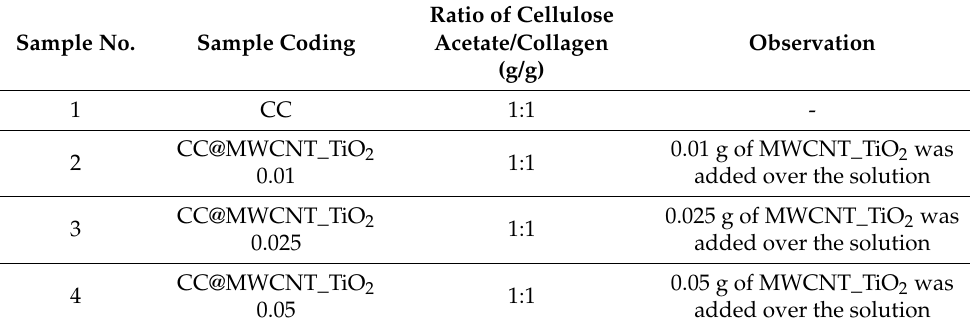
Table 1. Optimisation of